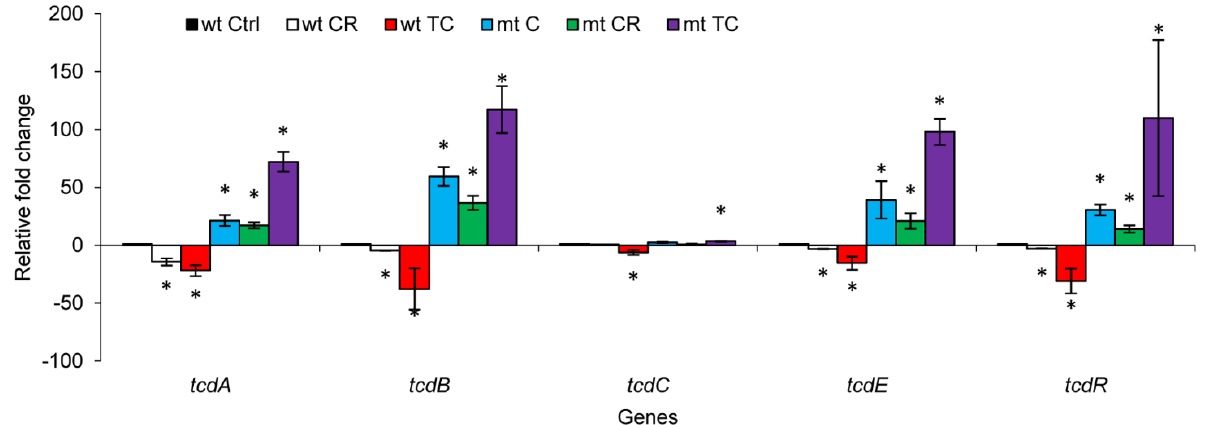
Figure 7. Effect of carvacrol (CR) and trans -cinnamaldehyde (TC) on codY mutant